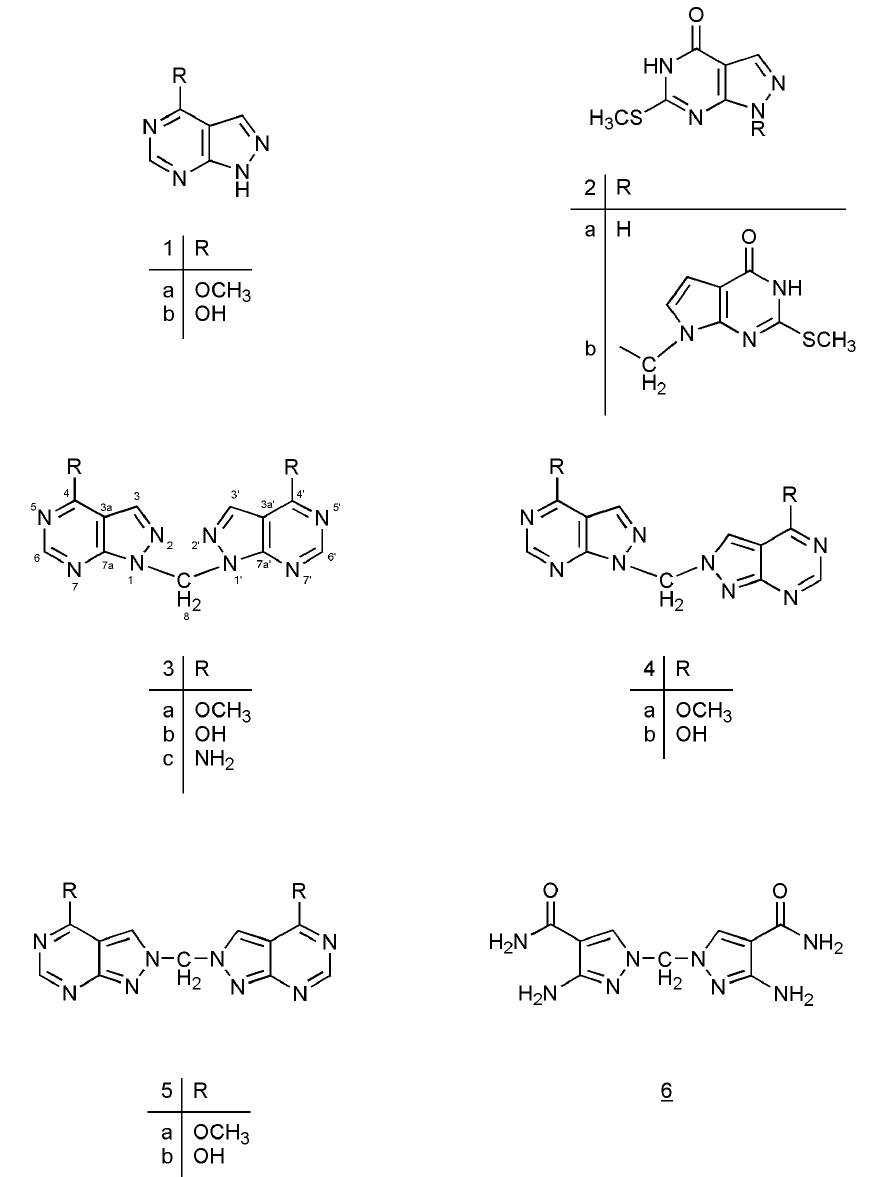
Figure 1. Chemical structures of novel